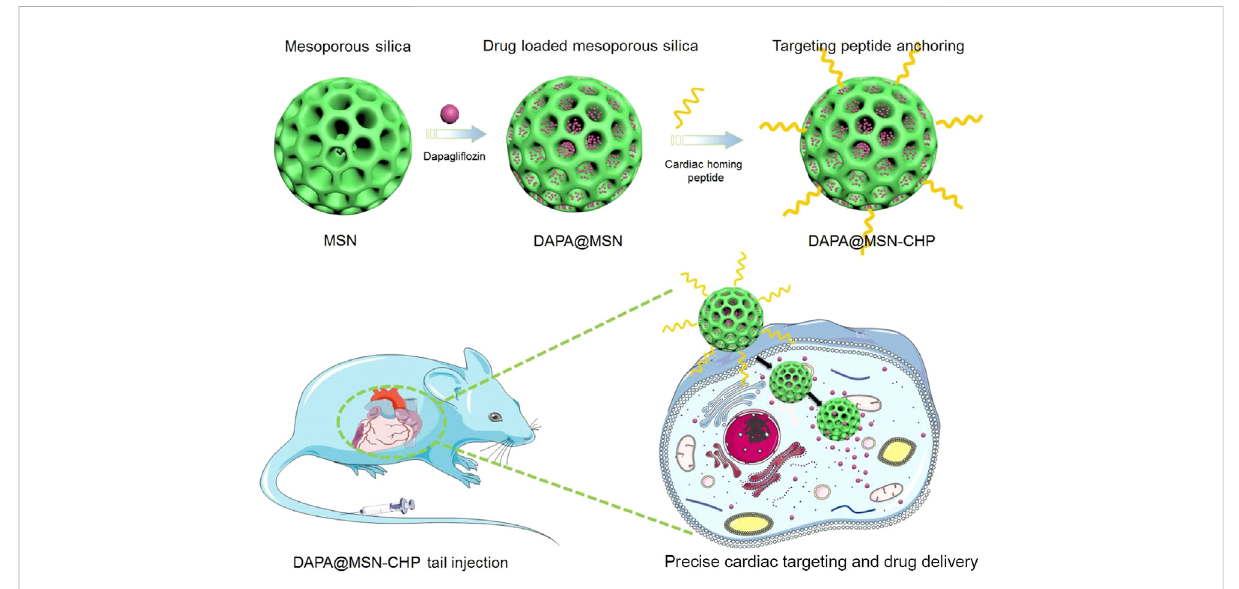
FIGURE 1 Dapagli fl ozin-loaded biocompatible mesoporous silica nanoparticles with surface functionalization of cardiac homing peptide fabrication for precise heart failure repair after myocardial